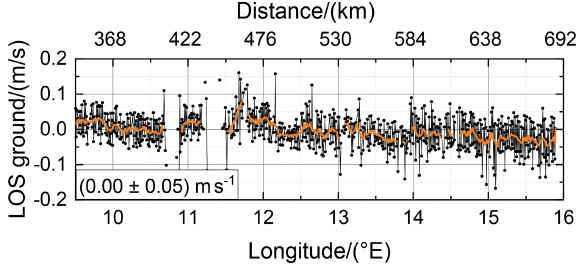
Figure 7. LOS wind speed retrieved from 2µmDWL ground re- turns (black) and moving average of 10 successive data points (or-